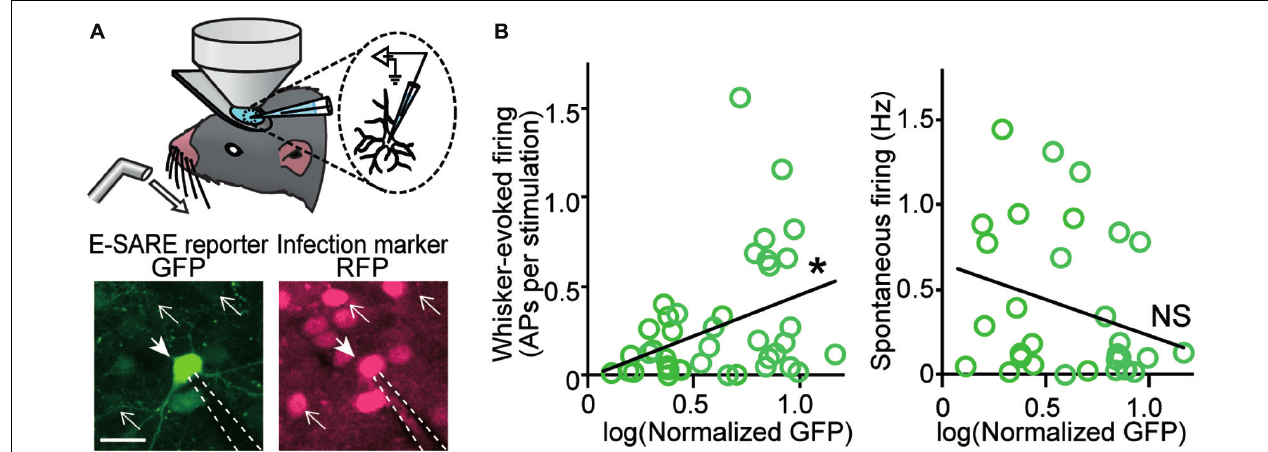
reporter-positive (filled arrow).The dashed lines and line arrows indicate the recording electrode and GFP-negative neurons, respectively. Scale bar, 20 μ m. (B) GFP brightness of recorded neurons correlates with their whisker-evoked activity (left) but not with spontaneous activity rate (right). Adapted from Kawashima etal.